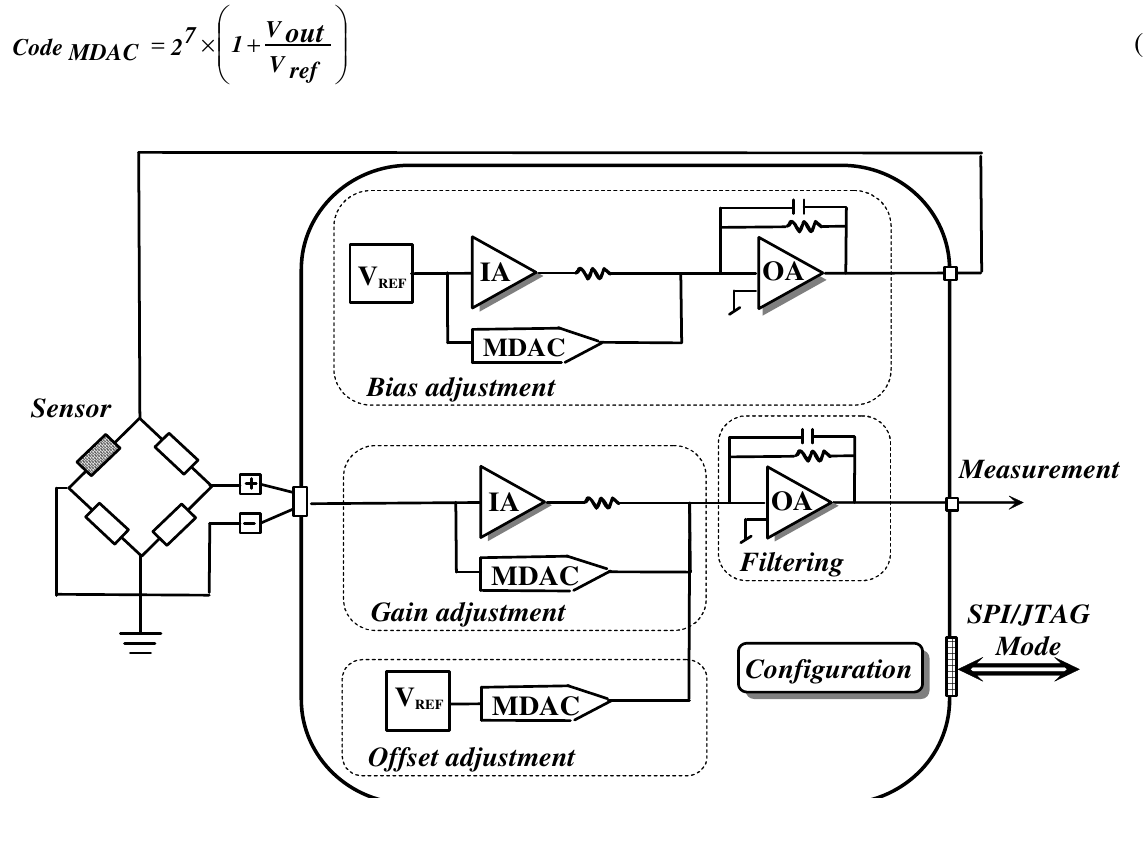
Figure 1 . Reconfigurable measurement